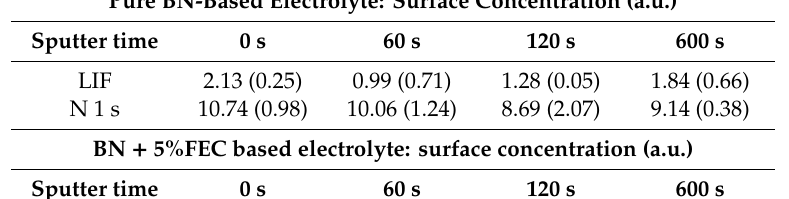
Table 4. Surface concentration on graphite in arbitrary unit (a.u.) of the performed XPS measurements using di ff erent BN-based